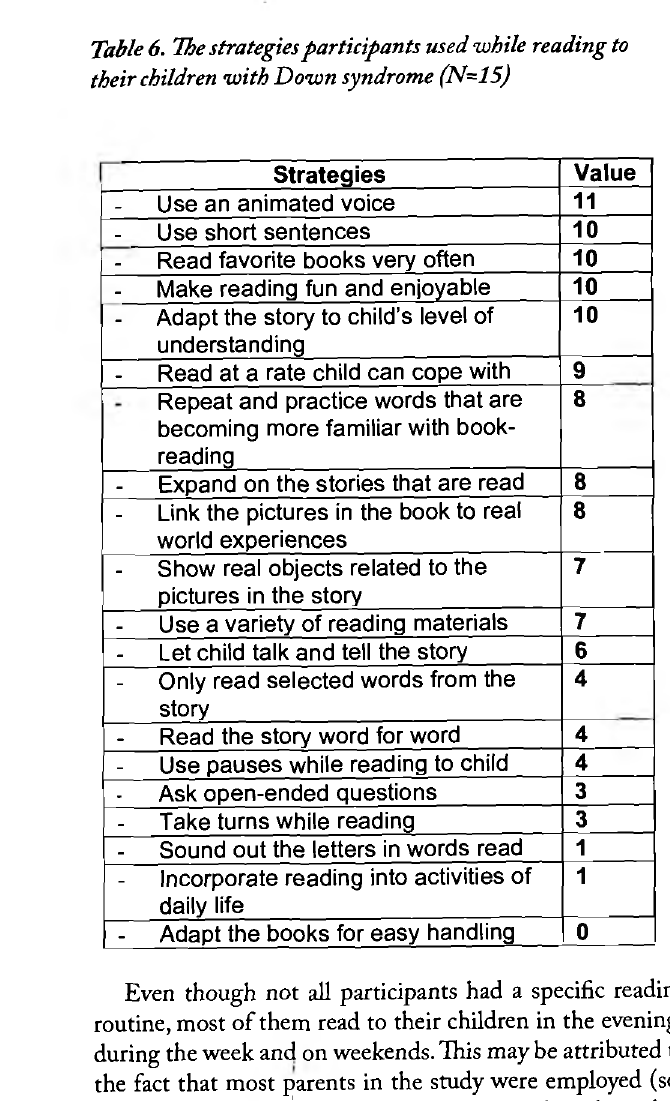
Table 6. The strategies participants used while reading to their children with Down syndrome (N=15)